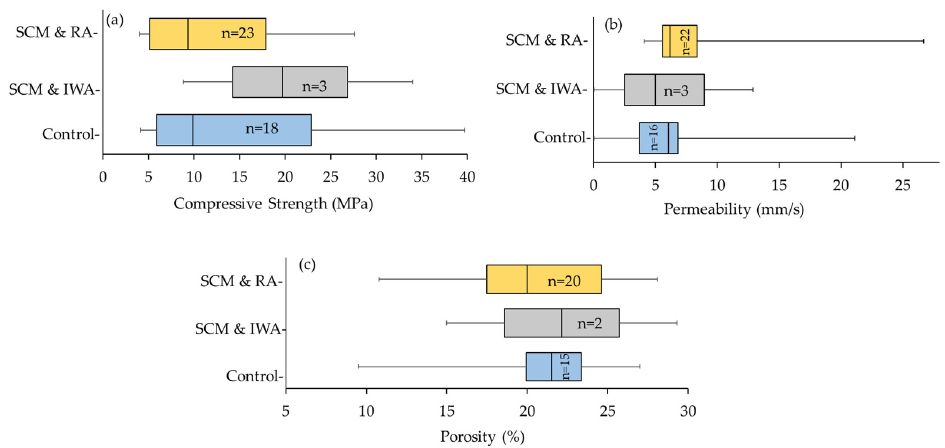
Figure 12. Variation in ( a ) Compressive strength, ( b ) Permeability, and ( c ) Porosity based on combined replacement (n = number of publications).